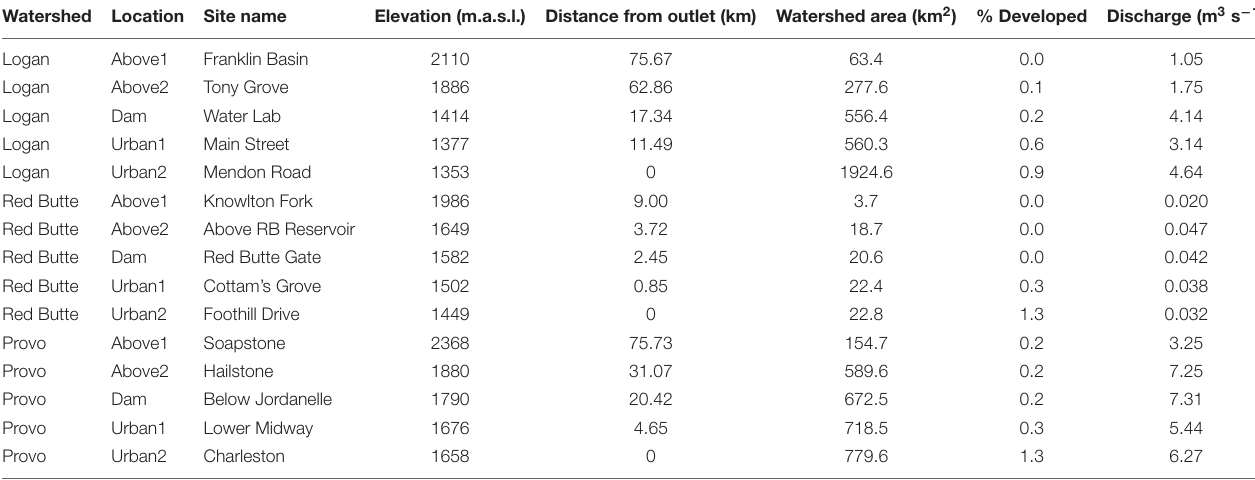
TABLE 1 | Stream site characteristics in the Logan, Red Butte, and Provo River Watersheds ( Figure 2 ). Watershed Location Site